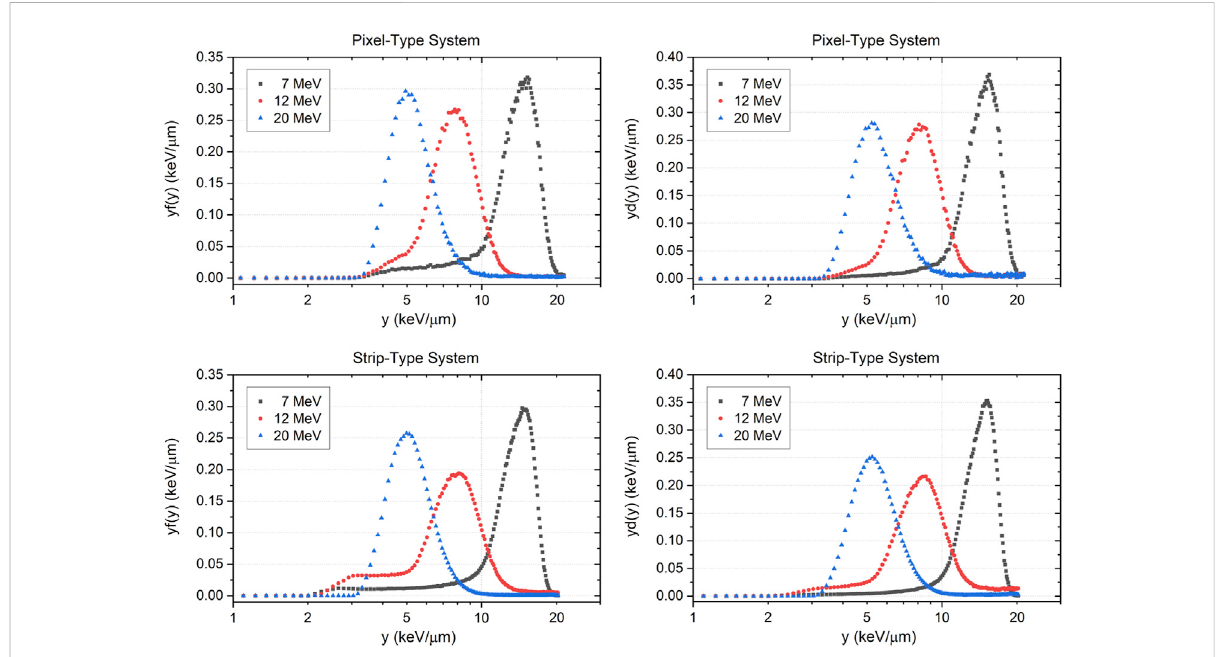
FIGURE 7 Lineal energy distribution y f ( y ), left, and absorbed dose distribution y d ( y ), right, obtained with the pixel (top) and the strip (bottom) systems for three different energies (values in silicon).